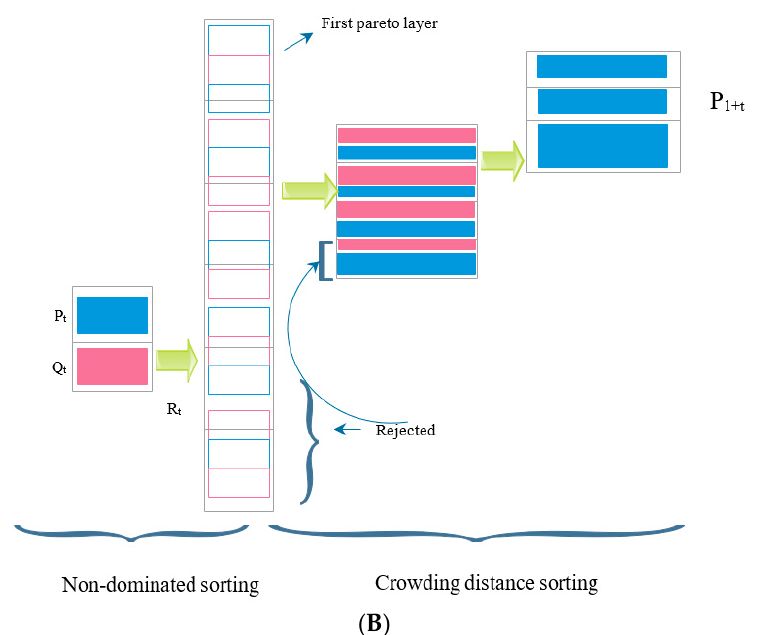
Figure 3. NSGA ‐ II procedure. ( A ) Convergence of the proposed algorithm; ( B ) Step of algo ‐ rithm.